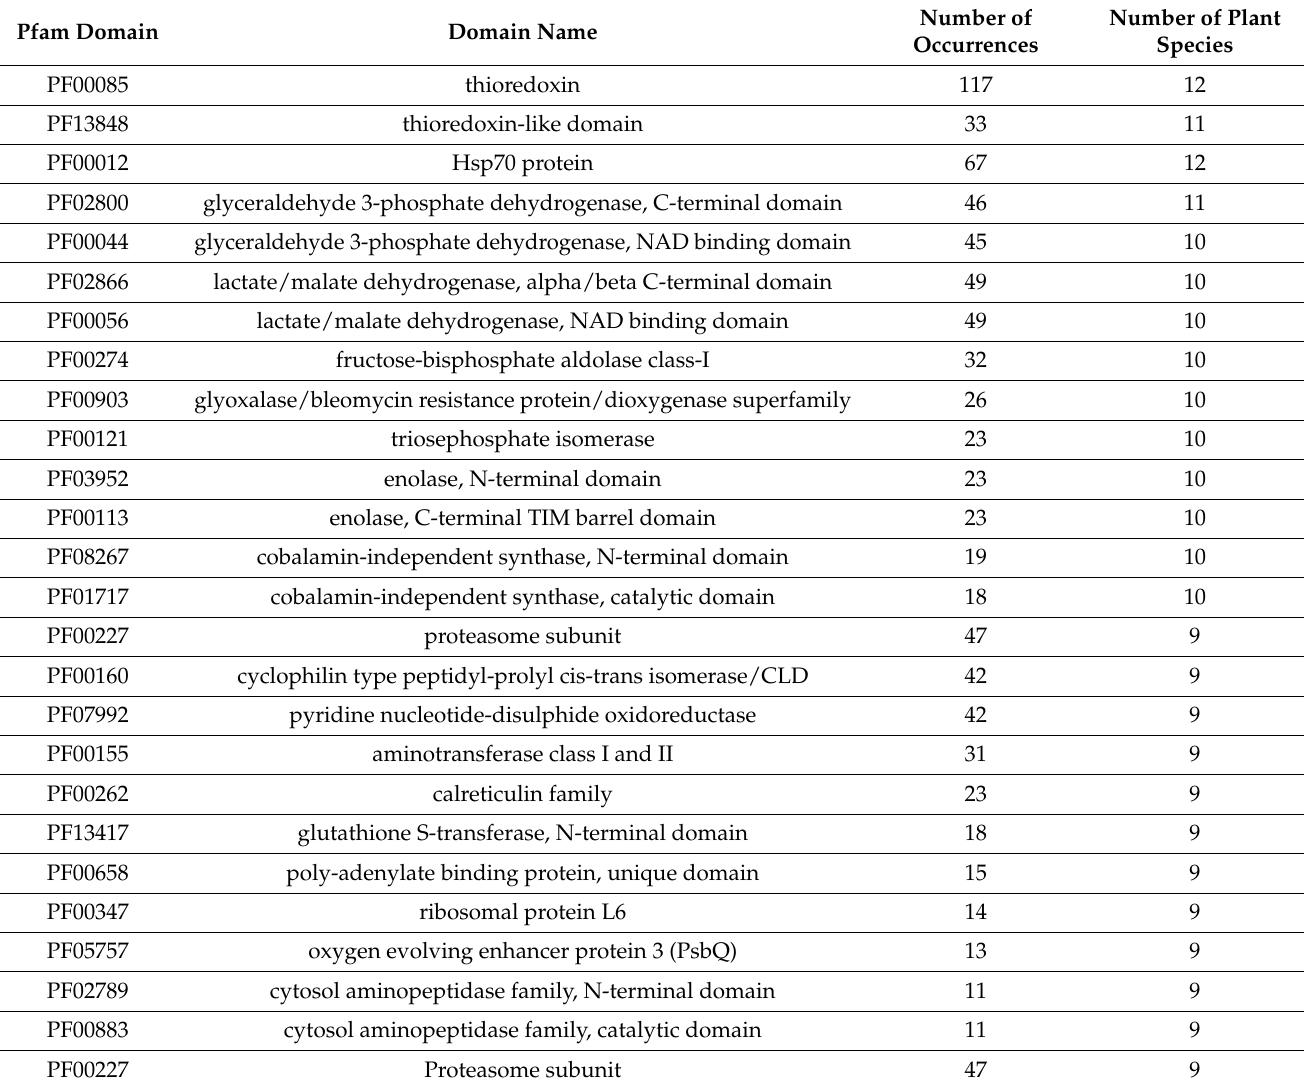
Table 3. The most represented Pfam domains in the proteins presumed to be contaminants in at least 9 out of the 12 studied cell wall